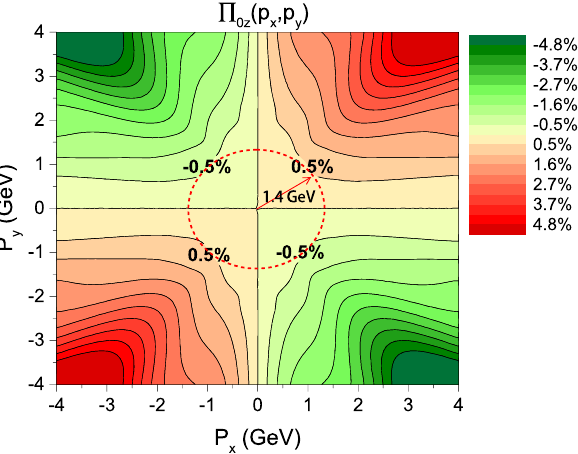
Fig. 3 Thetransversemomentumdistributionoflongitudinalpolariza- tion, Π 0 z , for Au–Au 200 GeV collisions with impact parameter ratio b 0 = 0 . 68 at rapidity bin | y | < 1